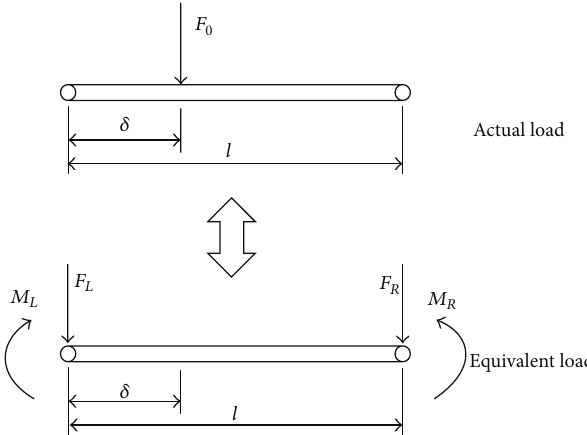
Figure 3: Equivalent nodal loads of the concentrated loads.